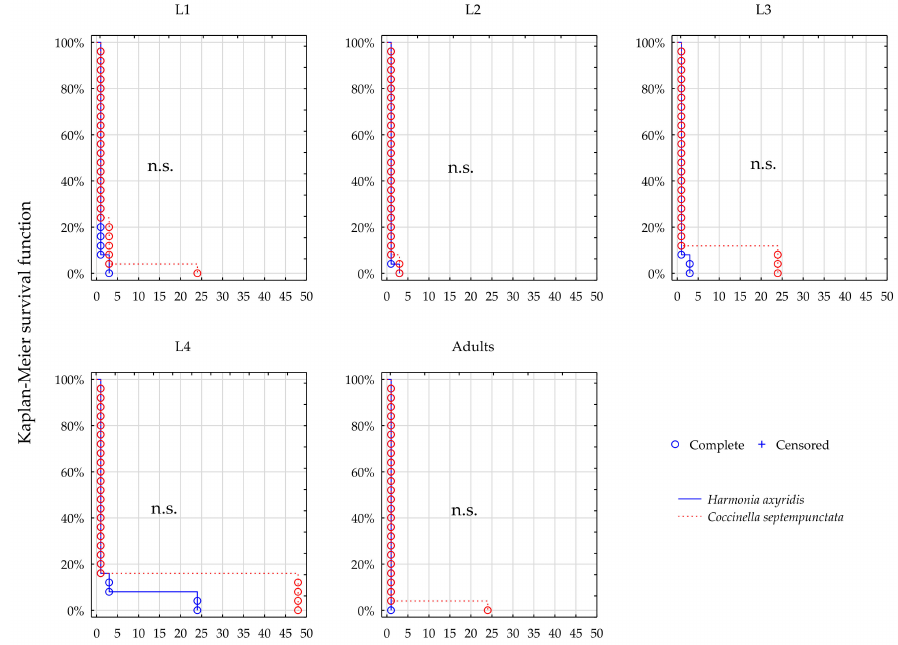
Figure 2. Survival dynamics of larvae and adults of the two predators after foraging on the prey treated with Karate Zeon at 50% recommended field